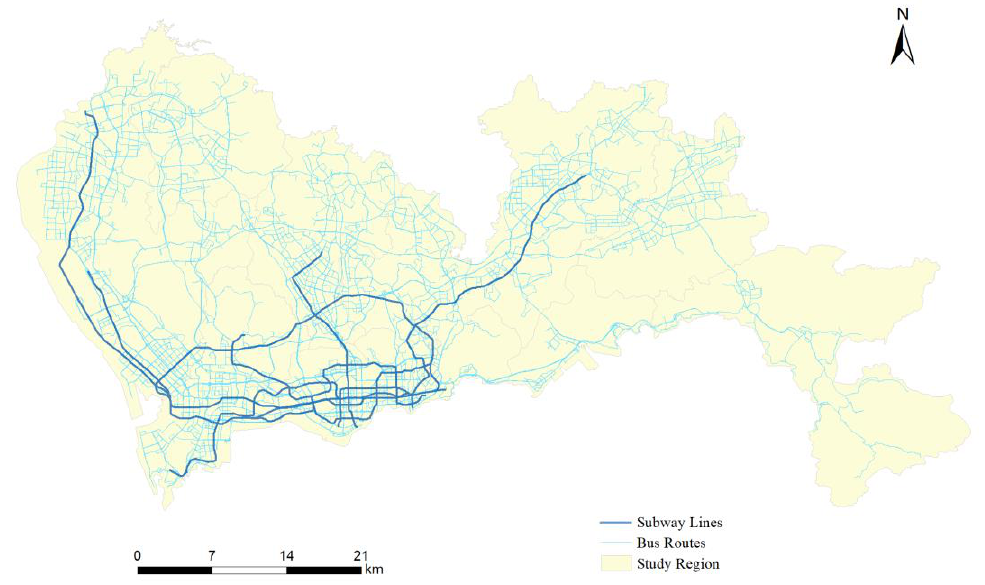
Figure 1. The study region and public transit